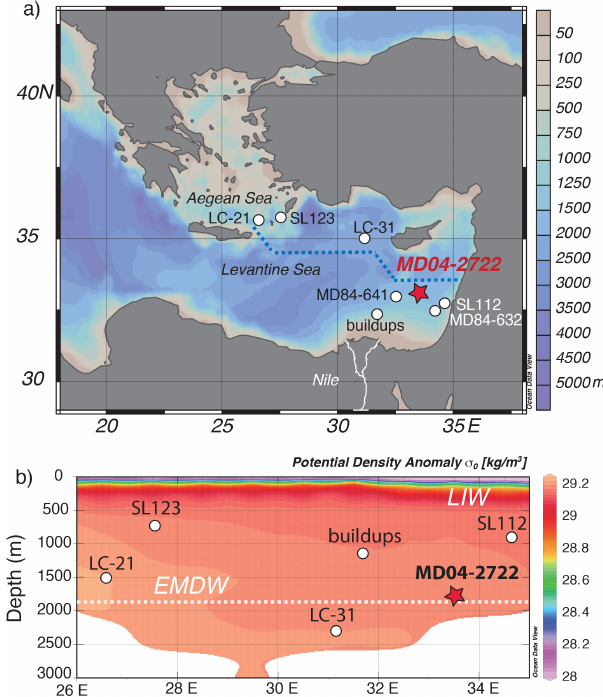
Figure 1. The core location map. (a) The core MD04- 2722 (33 ◦ 06 (cid:48) N, 33 ◦ 30 (cid:48) E, 1780m water depth) location on the bathymetry map. Site locations of the records discussed in the text are as follows: MD84-632: 32 ◦ 28.2 (cid:48) N, 34 ◦ 13.2 (cid:48) E (Essal- lami et al., 2007); MD84-641: 33 ◦ 02 (cid:48) N; 32 ◦ 28 (cid:48) E (Fontugne and Calvert, 1992); SL123: 35 ◦ 45.3 (cid:48) N, 27 ◦ 33.3 (cid:48) E (728m water depth); SL112: 32 ◦ 44.5 (cid:48) N, 34 ◦ 39.0 (cid:48) E (892m water depth) (Kuhnt et al., 2007); LC-21: 35 ◦ 39.7 (cid:48) N, 26 ◦ 35.0 (cid:48) E (1520m water depth); LC-31: 34 ◦ 59.8 (cid:48) N, 31 ◦ 09.8 (cid:48) E (2300m water depth) (Schmiedl et al., 2010); “buildups”: 32 ◦ 22 (cid:48) N, 31 ◦ 42 (cid:48) E (1160m water depth) (Bayon et al., 2013). (b) The present-day density anomaly transect along the dashed blue line at 34.5–35.5 ◦ N in Fig. 1a. The seawa- ter temperature and salinity are from WOA09 (World Ocean Atlas 2009) (Antonov et al., 2010; Locarnini et al., 2010). The dashed white line indicates the upper limit of the permanent anoxic layer during S1 deposition at 1800m (see the text for detail). Figures were generated using the Ocean Data View software (Schlitzer,